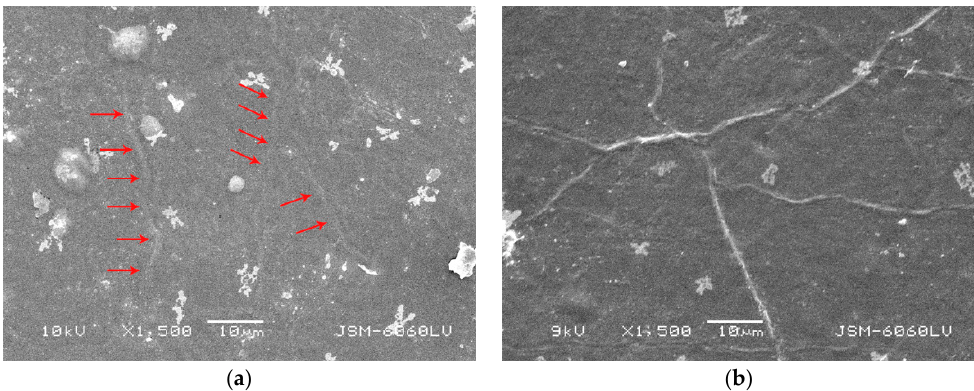
Figure 13. SEM images of photopolymer plate samples after swelling in IPA: ( a ) 10× UV treatment, ( b ) 30× UV treatment.